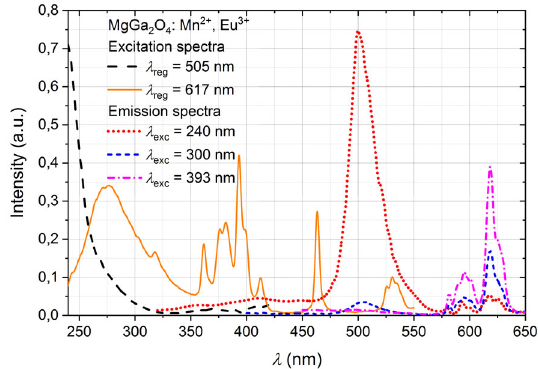
Fig. 9 PL excitation (black and red lines) and emission spectra (red, blue, and green lines) in MgGa 2 O 4 :Mn 2+ ,Eu 3+ ceramic